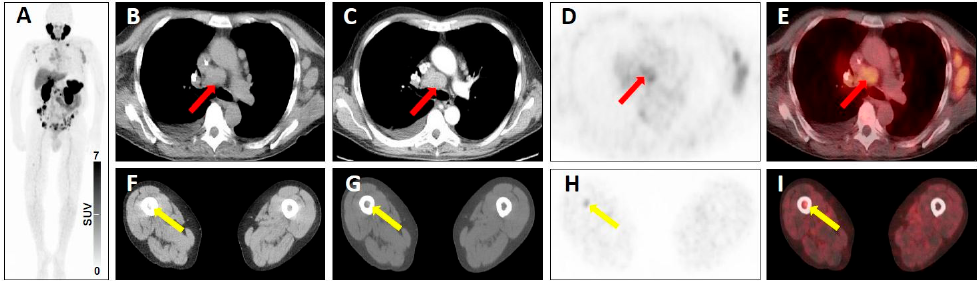
Figure 8. Equivocal uptake in soft-tissue and bone lesions on PSMA-targeted positron emission tomography (PET)/computed tomography (CT). 68 Ga-PSMA-11 PET/CT for restaging in a 66-year-old man with a history of a prostate cancer. Whole-body maximum intensity projection image showing multiple metastases to lymph nodes and to the bone with both clearly pathologic radiotracer uptake and equivocal radiotracer uptake ( A ). Axial low-dose CT image ( B ), contrast-enhanced CT image ( C ), PET image ( D ), and fused PET/CT image ( E ) showing a mediastinal lymph node typical of a prostate cancer lesion on anatomic imaging, but with equivocal uptake (red arrows), consistent with a PSMA-RADS-3A lesion. Axial soft-tissue window CT image ( F ), bone-window CT image ( G ), PET image (H) and fused PET/CT image (I) showing a bone marrow lesion not atypical of a prostate cancer lesion on anatomic imaging, but with equivocal uptake (yellow arrows), consistent with a PSMA-RADS-3B lesion.